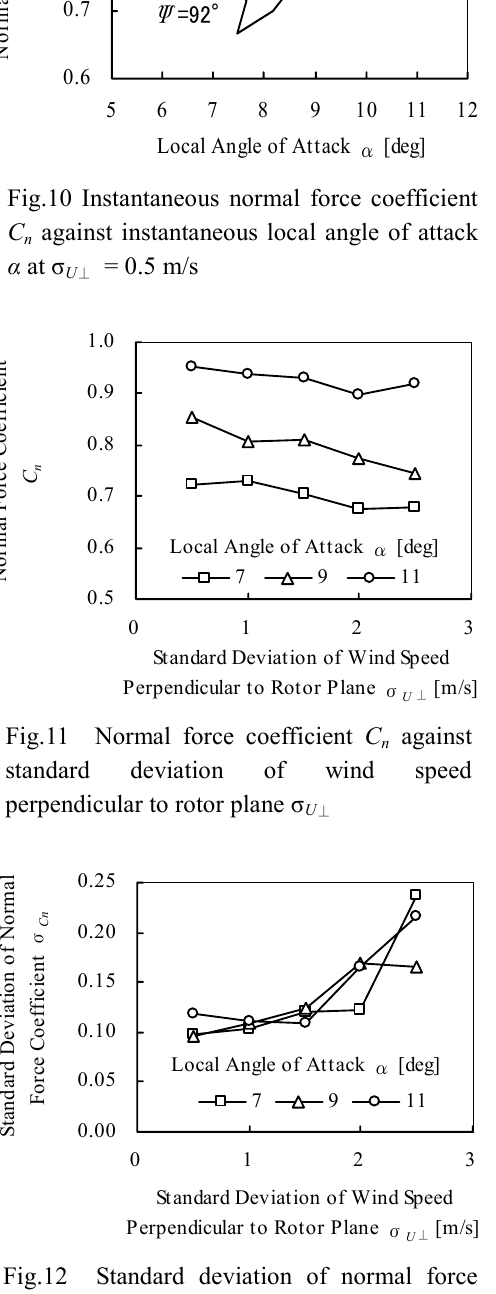
the south side. On the other hand, the mean value of standard deviations of the wind =1.0 m/s as shown in Fig.7. velocity during one rotor revolution is larger than those for σ U ⊥ This is caused by a reduction in the wind velocity due to the hill on the north side. The value can be seen as due to the spatial non-uniformity of the wind. Figure change in σ U ⊥ 8(b) shows the profiles of wind 0.60.70.80.91.0 velocity in a direction parallel to the , and its standard rotor plane, U || deviation. A spatial and time-dependent difference in the data is apparent, similar phenomena to those shown in Fig. 7(b). The wind shear caused by the spatial non-uniformity is discussed below.